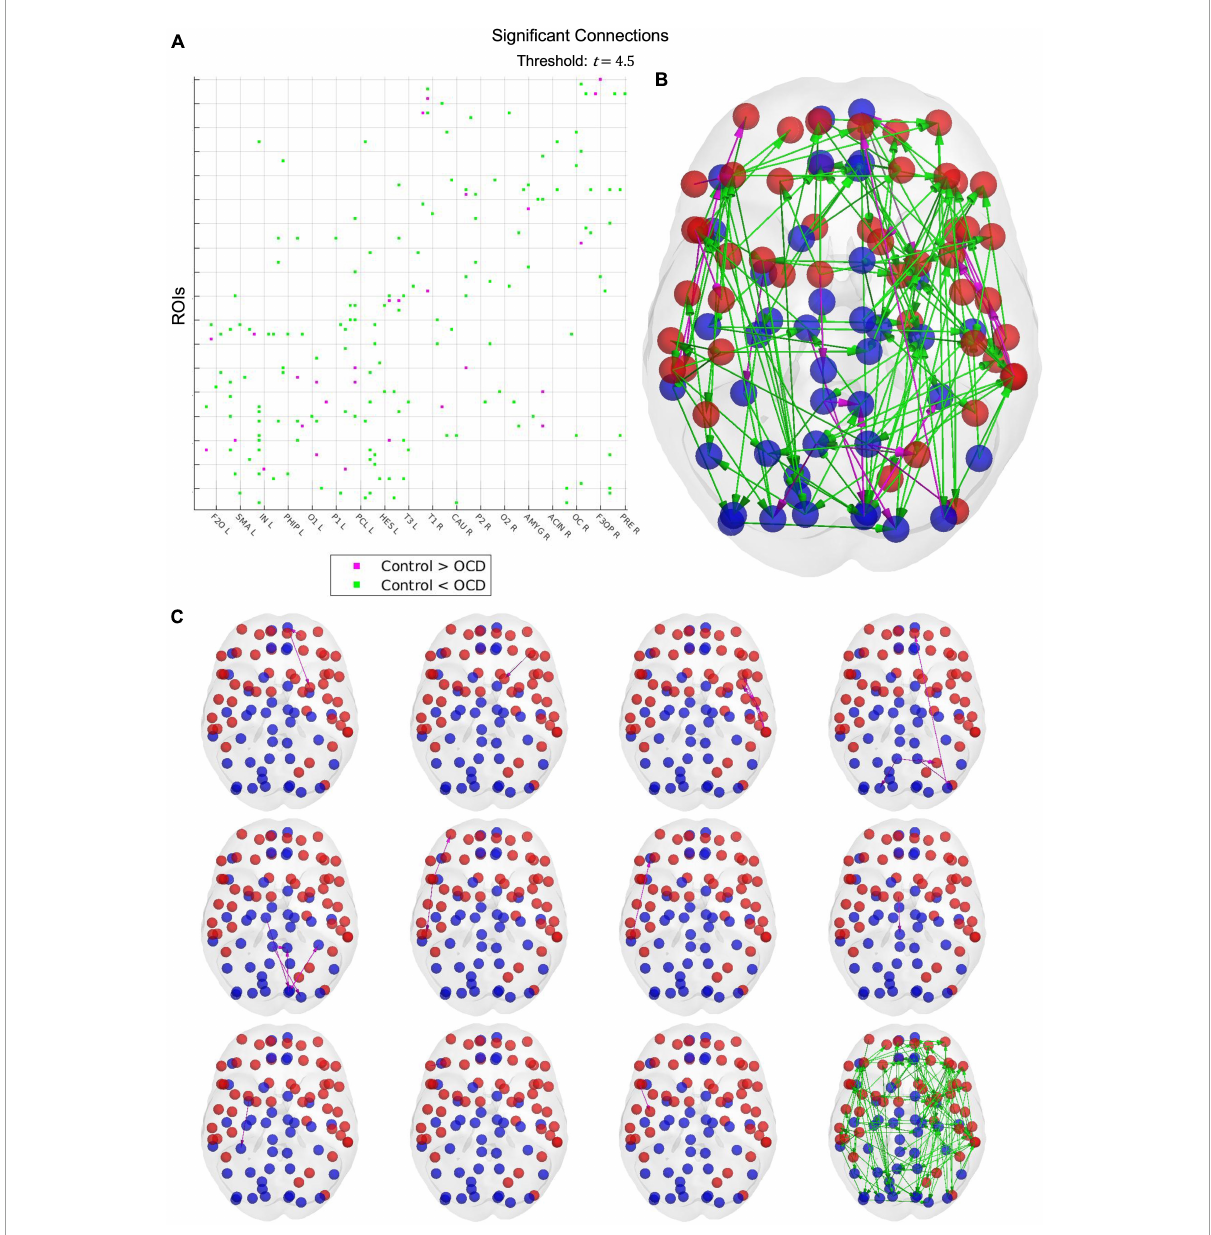
FIGURE5 Results from the network-based statistic. A t-statistic threshold of 4.5 returns 12 connected components (C) , visualized together as a connectivity matrix (A) and in cortical space (B) . Cyan links indicate that the connection is stronger in OCD patients than in healthy controls, while magenta links indicate the converse. Although only one connected component displays increased strength in patients, this component includes 87 of the 90 cortical nodes in the AAL parcellation, suggesting that obsessive-compulsive disorder may be characterized by widespread cortical hyperconnectivity. The 11 control-biased components, by contrast, consist of between one to six links, with larger components tending to concentrate in small topographical areas. Notably, many regions displaying depressed connectivity in patients are known to be involved in top-down control and impulse inhibition. OCD may thus be characterized by localized disruptions in top-down inhibitory activity, which may explain the widespread hyperconnectivity observed in patients.